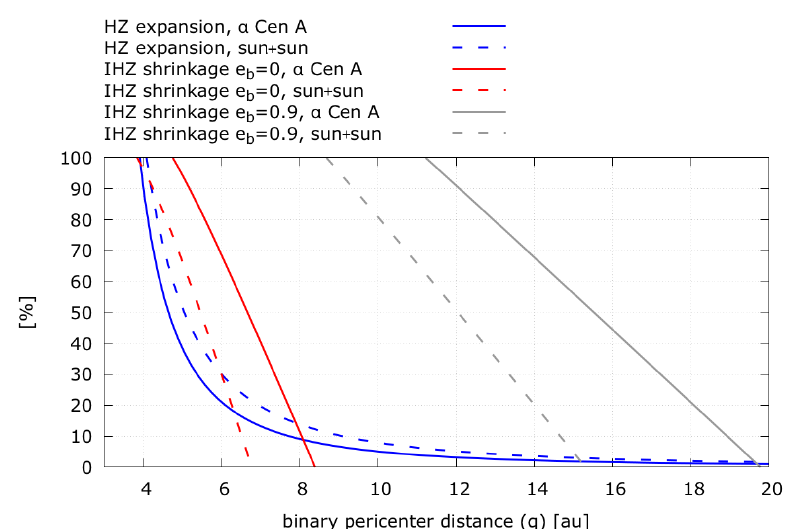
Figure 5. The different rates of displacement of the isophote-based habitable zone borders in Figure 4 lead to an expansion of the isophote-based habitable zone compared to the single star habitable zone. At the same time orbital stability restrictions shrink the size of the isophote-based habitable zone. A shrinkage of 50% means that the outer half of the isophote-based habitable zone is dynamically unstable whereas a shrinkage of 100% means that no planet can remain on a stable orbit in the isophote-based habitable zone. Expansion and shrinkage of the isophote-based habitable zone are computed with respect to the primary of an α Centauri like system and a binary consisting of two sun-like G2V